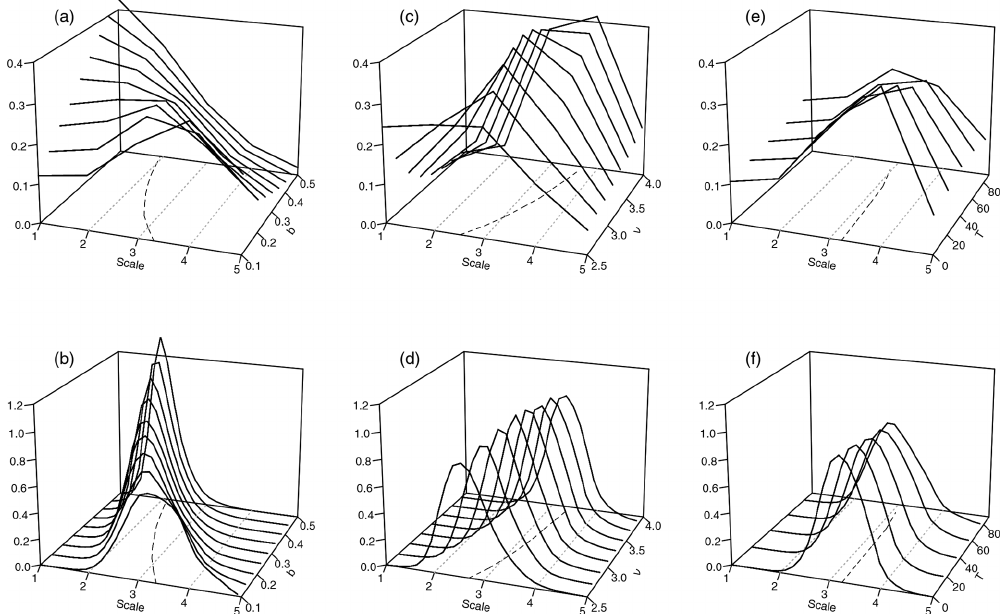
Figure 4. Mean spectra (a, c, e) and histograms of central scale (b, d, f) , as functions of the scale parameter b at ν = 2 . 5 (a, b) , smoothness parameter ν at b = 0 . 25 (c, d) , and threshold T at b = 0 . 1 and ν = 2 . 5 (e, f) . Dashed lines in the x – y -plane indicate the respective curve centres of mass; dotted grey lines (parallel to the y axis) were added for